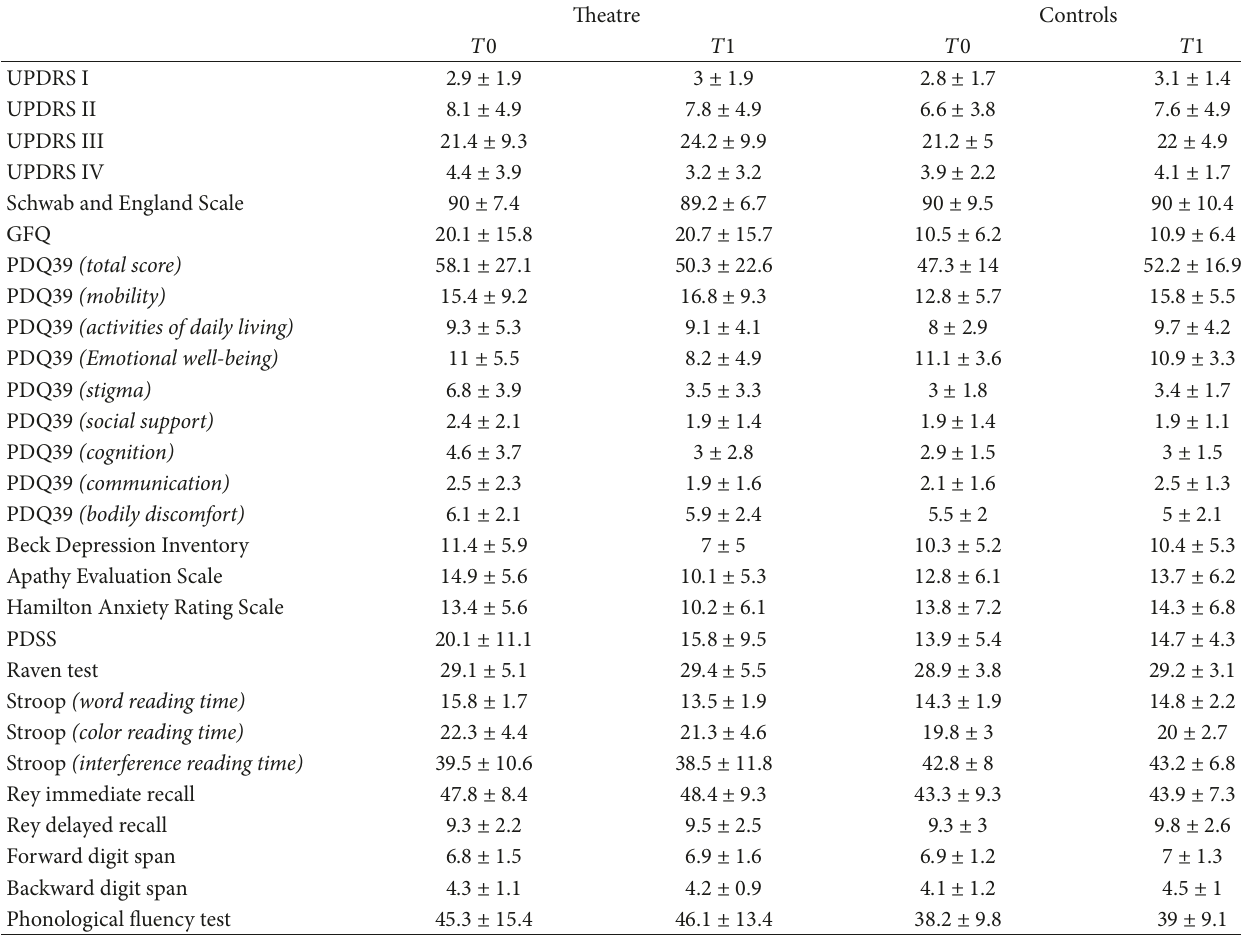
Table 5: Mean scores and standard deviations obtained by the two groups of PD patients (theatre group and control group) in all clinical scales and subscales at the beginning ( 𝑇0 ) and the end ( 𝑇1 ) of the rehabilitation